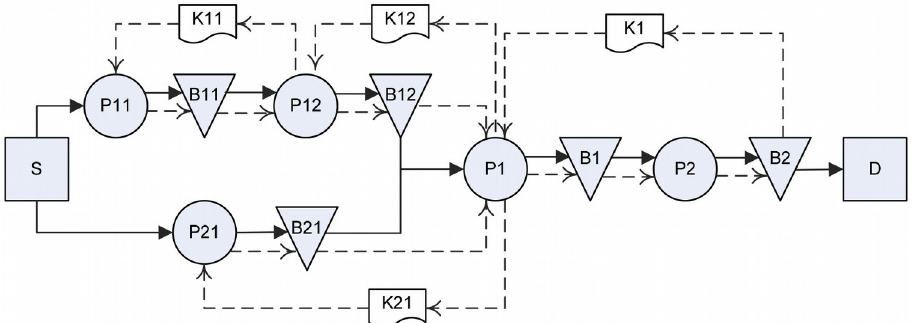
Figure 6. Conceptual mechanism of Hybrid2 (A4)